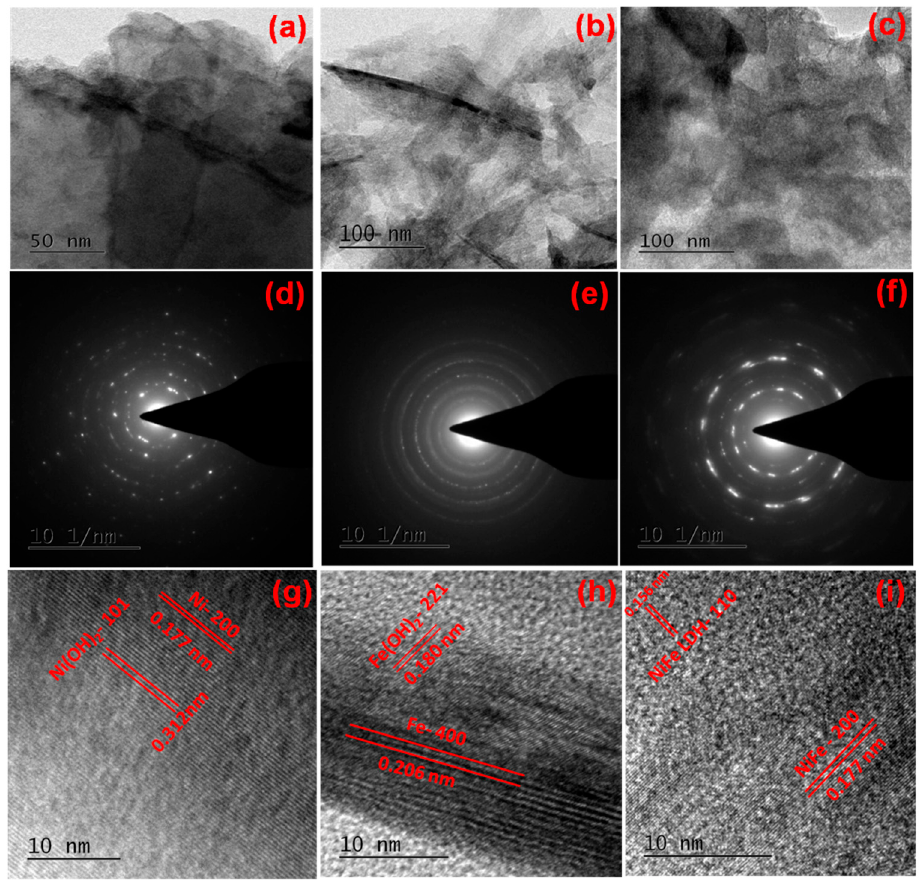
Figure 4. HR-TEM images ( a – c ), SAED pattern ( d – f ), and the corresponding lattice fringes ( g – i ) of Ni on TC, Fe on TC, and NiFe-LDH on TC, respectively. on TC, Fe on TC, and NiFe-LDH on TC,